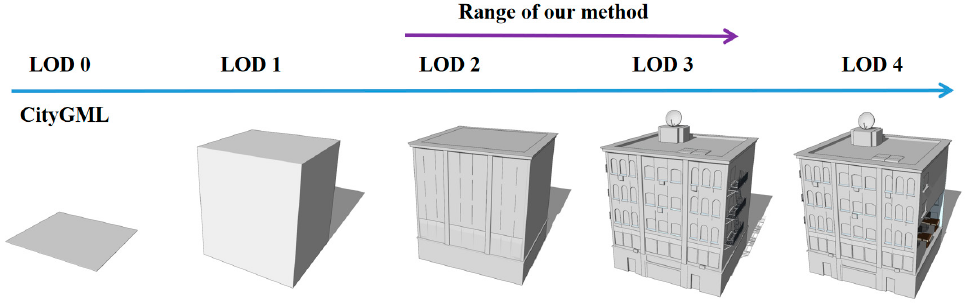
Figure 18. The range of our method and the LODs of CityGML.